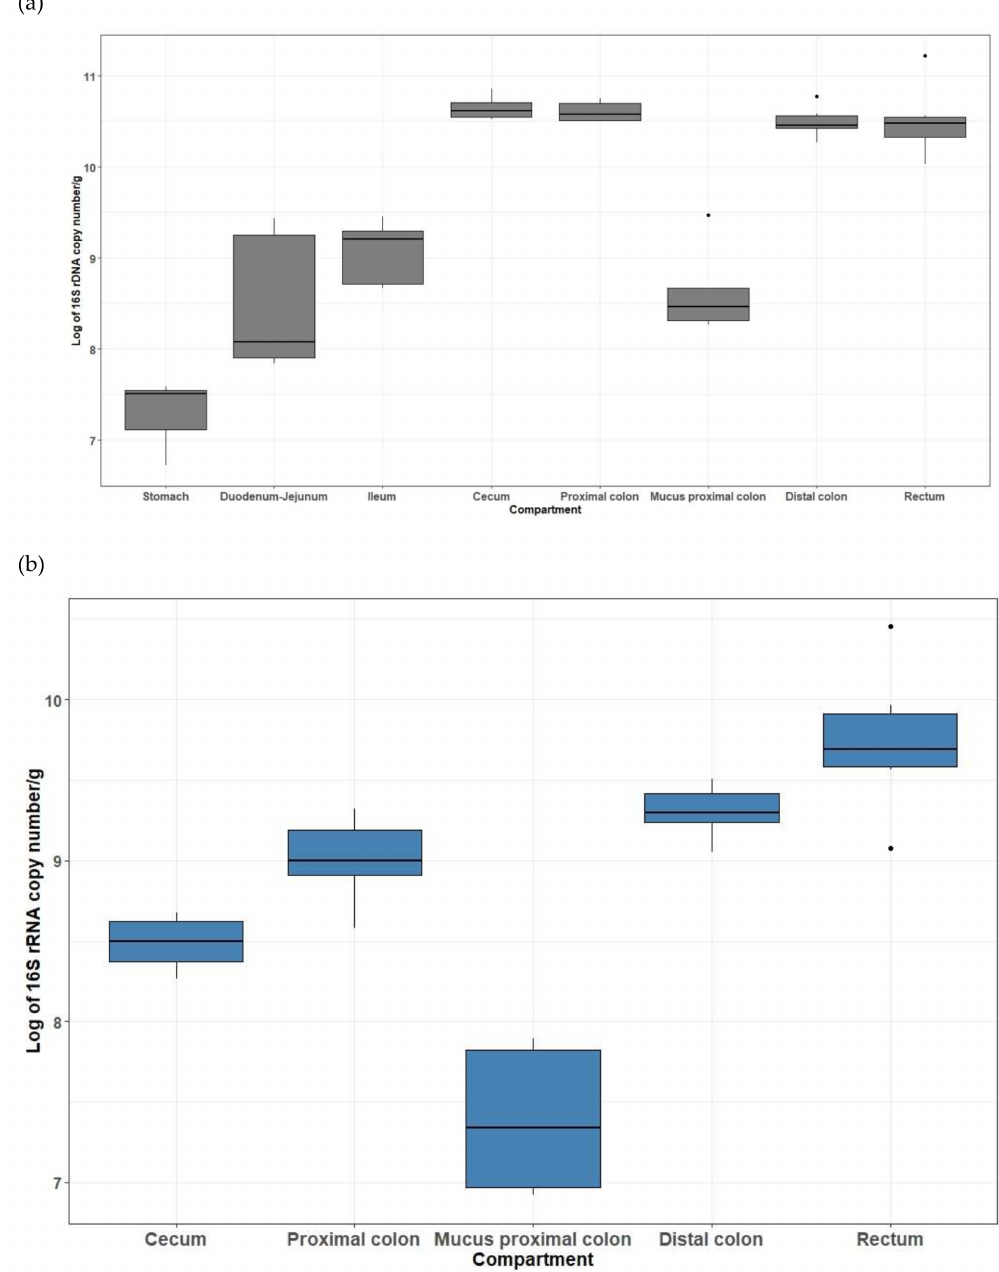
Figure 1. Quantification of total bacteria ( a ) and archaea ( b ) populations along the GIT of weaning piglet using qPCR on the 16S rRNA